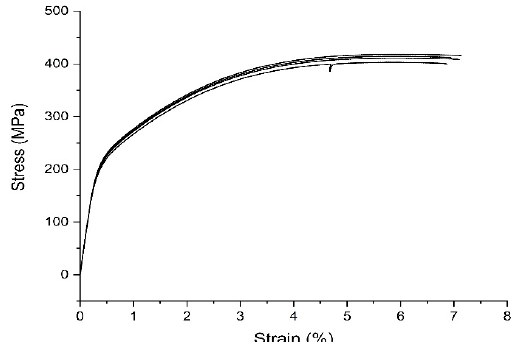
Figure 9. Tensile curves of the L-PBF AlSi10Mg alloy with a platform temperature of 160 °C. Table 4. Tensile properties of the L-PBF processed AlSi10Mg alloy.